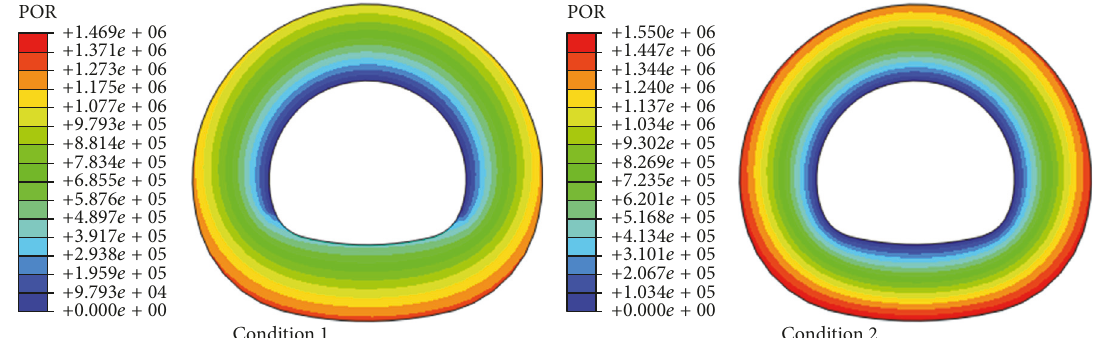
Figure 7: The distribution of pore water pressure in the 5 m range of tunnel excavation.